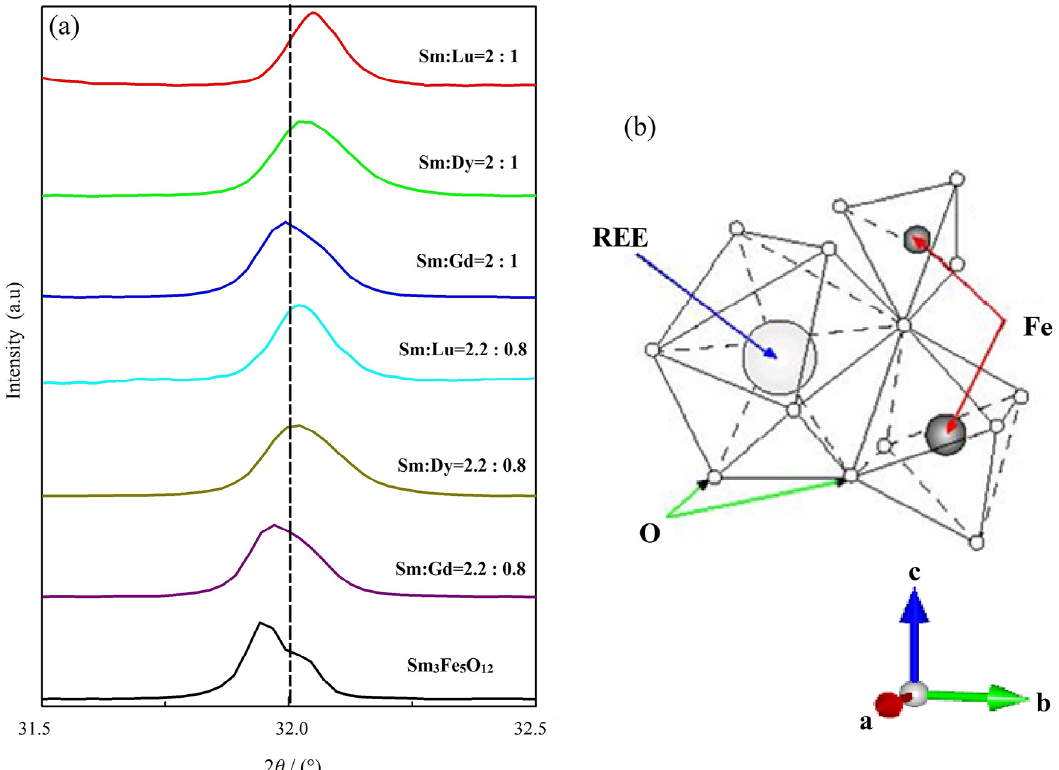
REE Fe O system (REE= Gd, Dy and Lu) with x = 0.0, 0.8 and 1.0, (b) 3− x x 5 12